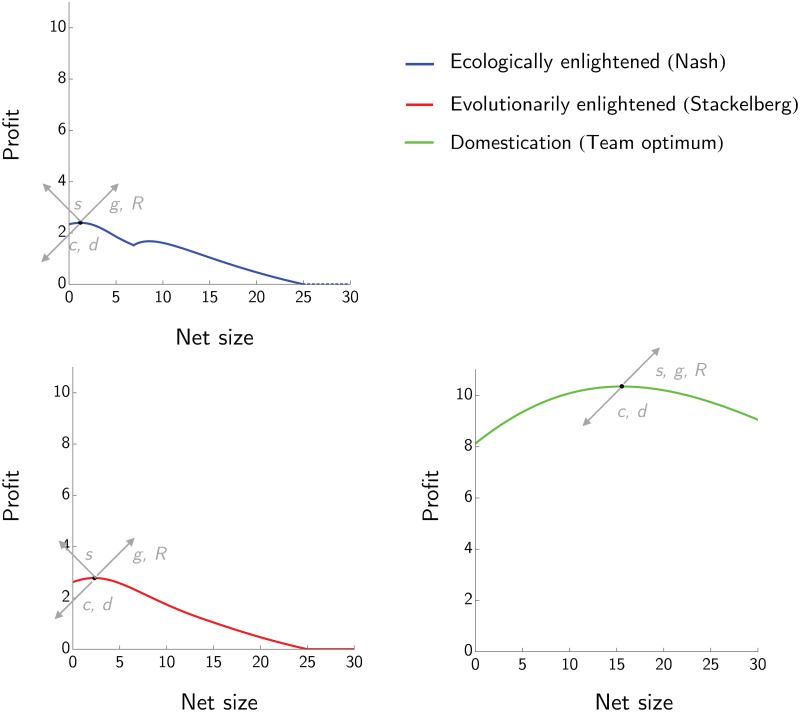
Sensitivity analysis of the three equilibria for the case where the manager can set both the harvesting rate and the net size.Sensitivity analysis showing how how profit and net sizes change with respect to the intensity of density dependence R, the maximum fecundity rate s, the natural mortality rate d, the growth rate of juveniles g and the cost of fishing c. The profit of the ecologically enlightened (Nash) manager and of the evolutionarily enlightened (Stackelberg) manager are directly proportional to s, R and g and inversely proportional to c and d. The optimal net size of both managers increases when g or R increase and decreases when s increases. Moreover, the optimal net size of both managers decreases with c and d. The profit from domestication and the corresponding optimal net size increase with s, R and g and decrease with c and d.